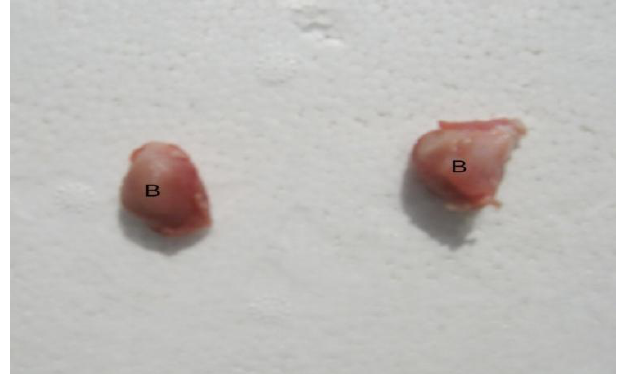
Figure 7: The bulbourethral gland (B) of the